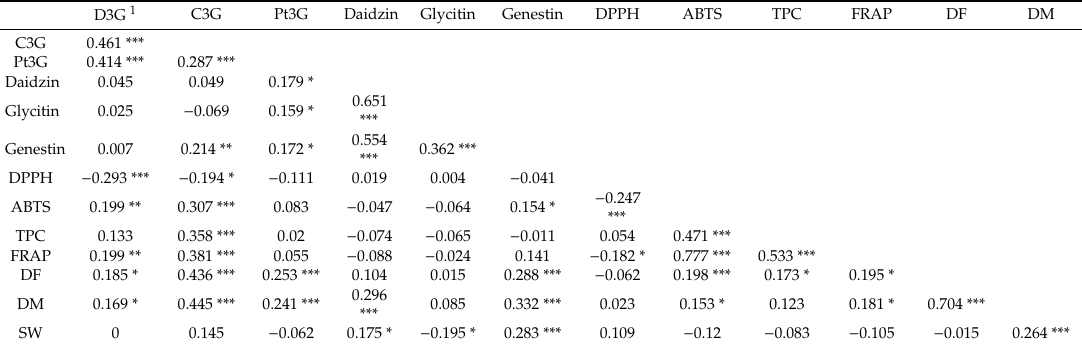
Table 3. Correlations between agricultural traits, anthocyanins, isoflavones, and antioxidant activities in 172 Korea black soybean landraces. D3G